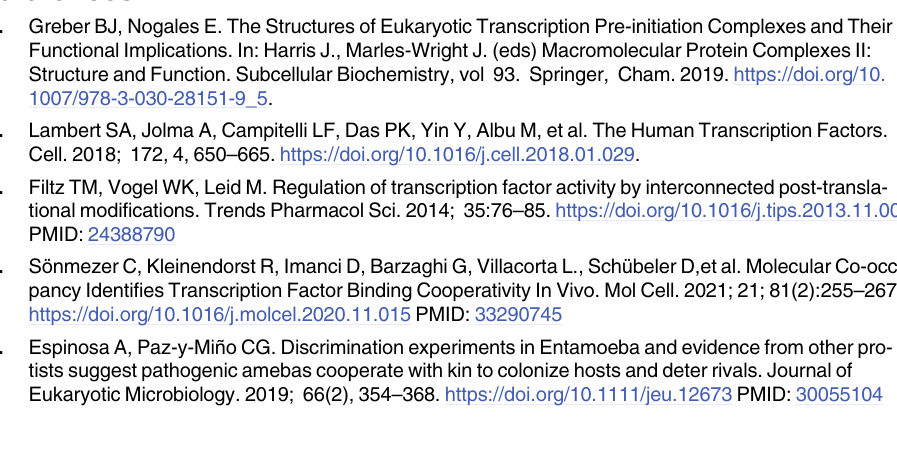
S2 Table. Gene regulatory networks of Entamoebas strains. S3 Table. Gene ontology terms of Entamoebas networks. S4 Table. Main topological